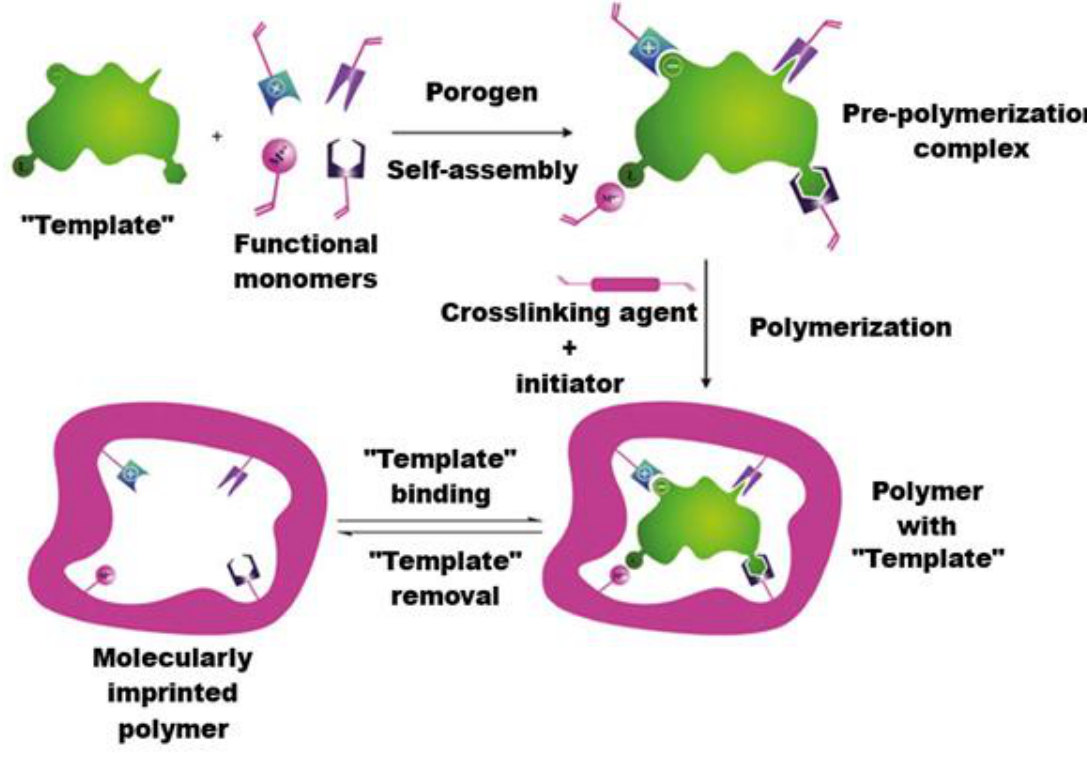
Figure 2. MIP synthesis stages.